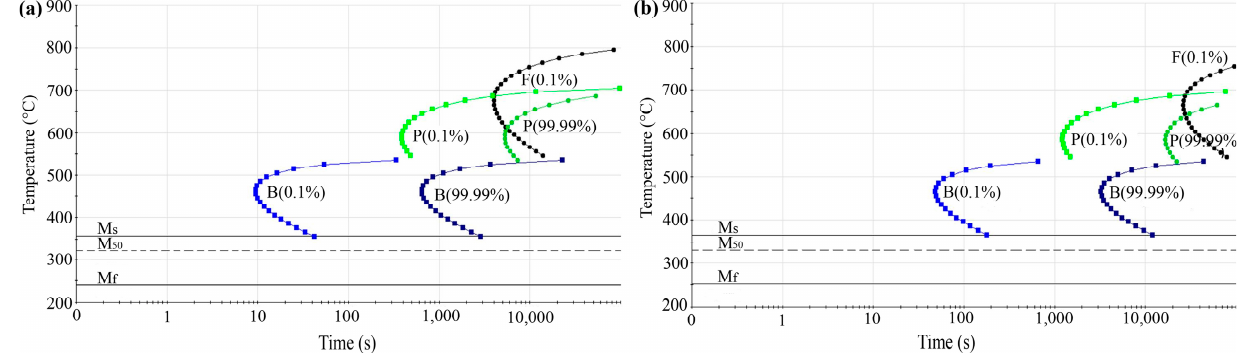
Figure 8. Hardenability curves obtained by JMatPro software: ( a ) CP-B0 steel and ( b ) CP-B60 steel.